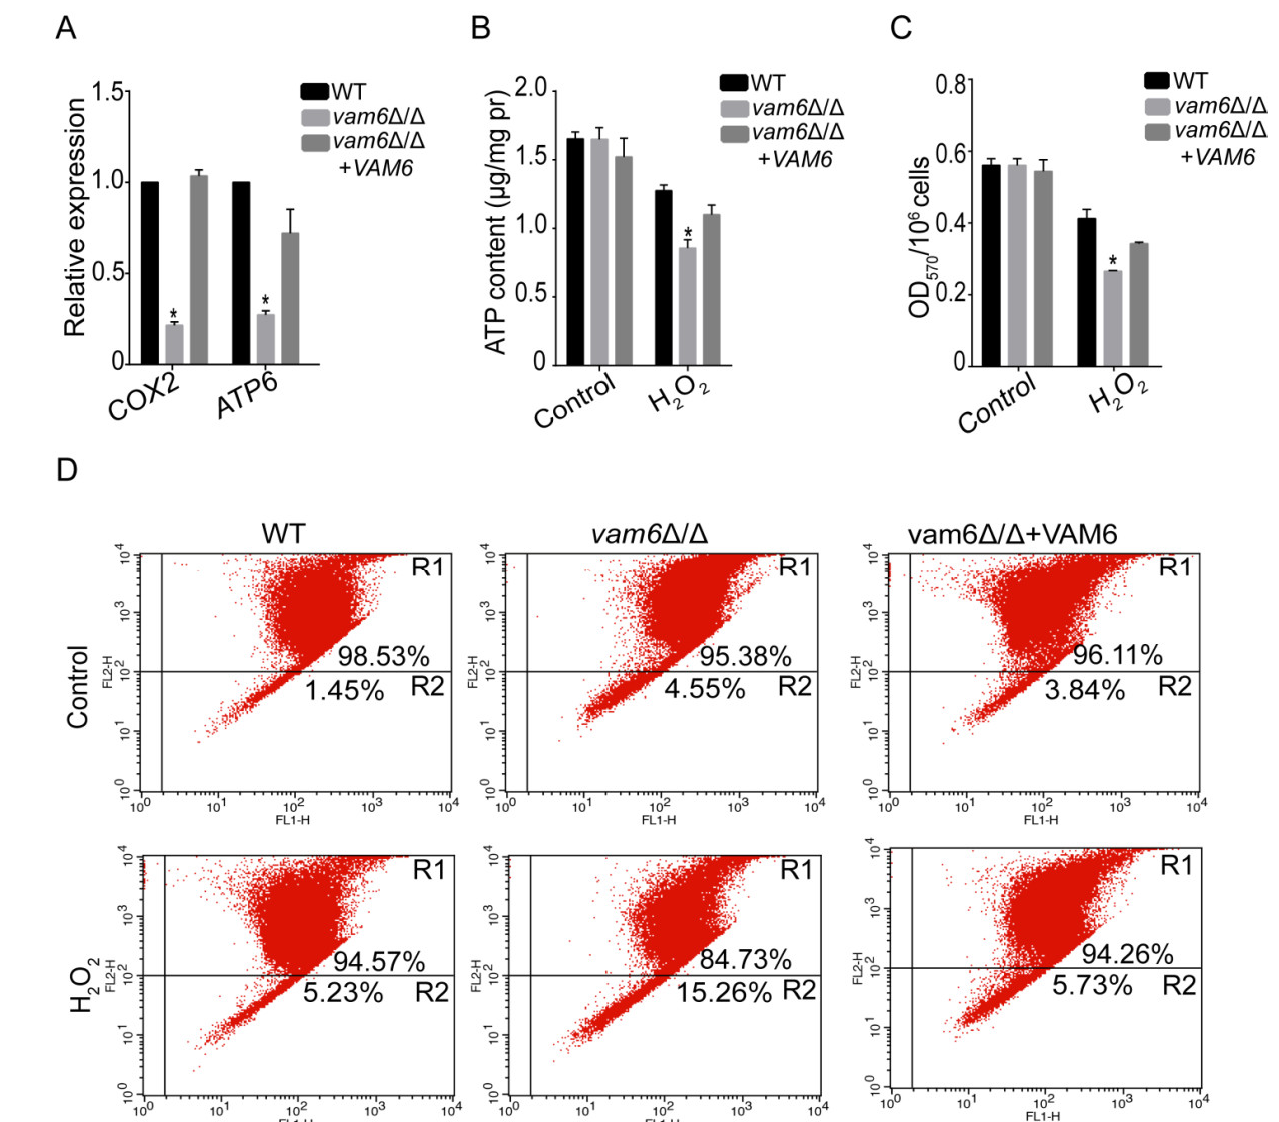
Figure 5. Deletion of VAM6 affects mitochondrial functions under oxidative stress. ( A ) Effect of VAM6 deletion on mtDNA quantity after cultured for 4 h under oxidative stress. The mtDNA encoding genes COX2 , ATP6 were analyzed by RT-PCR using ACT1 as the normalization gene. ( B ) Intracellular ATP levelsmeasured by an ATP detection kit. ( C ) Impact of VAM6 deletion on mitochondrial SDH activity. Cultures were mixed with MTT and incubated at 30 ◦ C for 2 h, and then collected. The pellets were then resuspended in DMSO. The suspensions were centrifuged, and OD 570 of the supernatants was measured. ( D ) Effect of VAM6 deletion on mitochondrial membrane potential revealed by JC-1 staining and flow cytometry. The cells were collected, resuspended in PBS and incubated with JC-1 for 30 min at 37 ◦ C. Gated region R1 represents cells with intact mitochondrial membranes and gated region R2 shows cells with loss of mitochondrial membrane potential. This value represents the mean ± SD from three replicates. * Significant difference between mutants and control strains, p < 0.05.